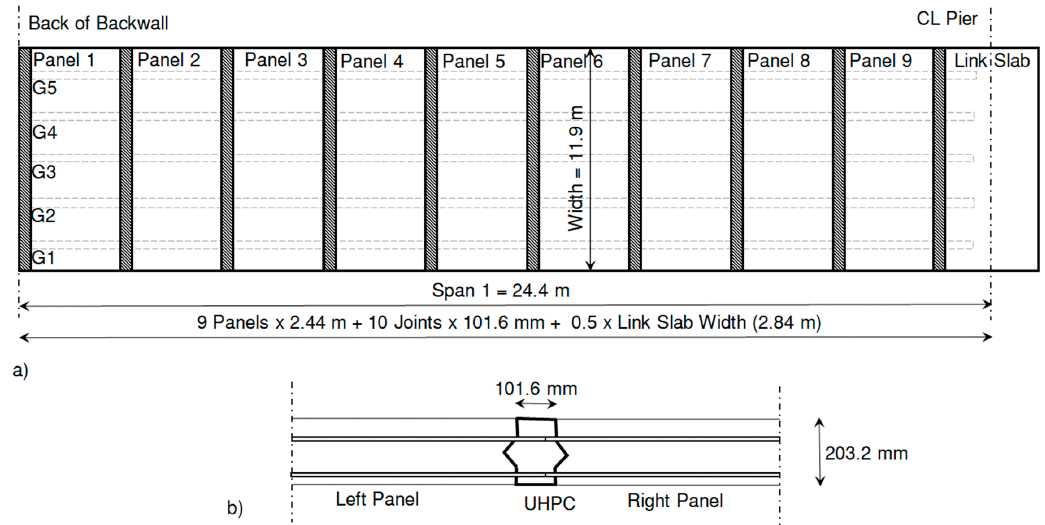
Figure 12. Bridge example with precast deck panel using UHPC joints: ( a ) panel layout; ( b ) joint size.